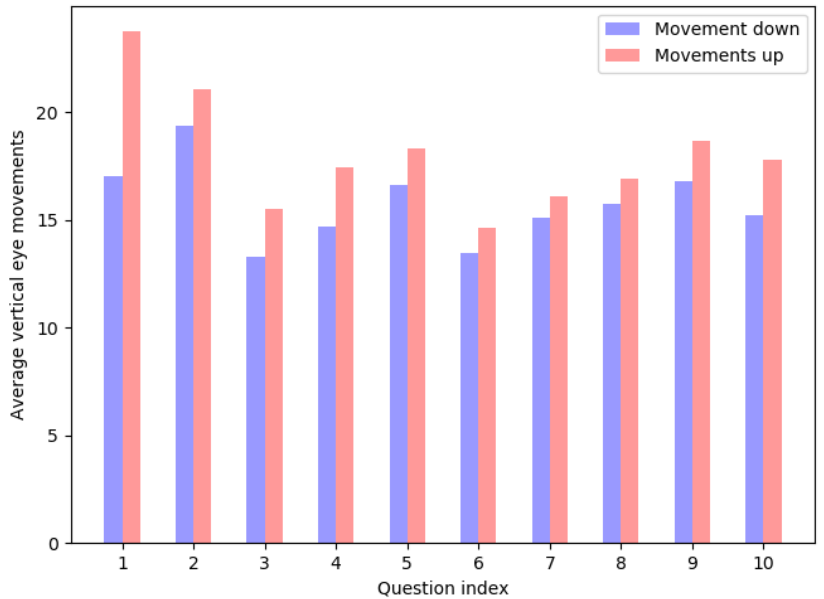
Figure 12. Average vertical saccadic gaze shifts on the Silesian face database. The subjects told the truth on questions 1, 2, and 9 and lied for the other